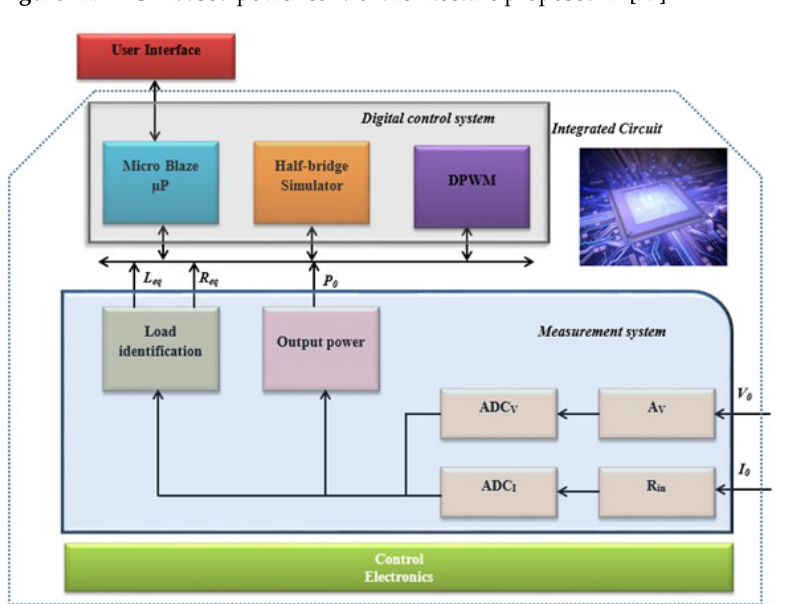
Figure 23. FPGA-based on line hardware loop emulator